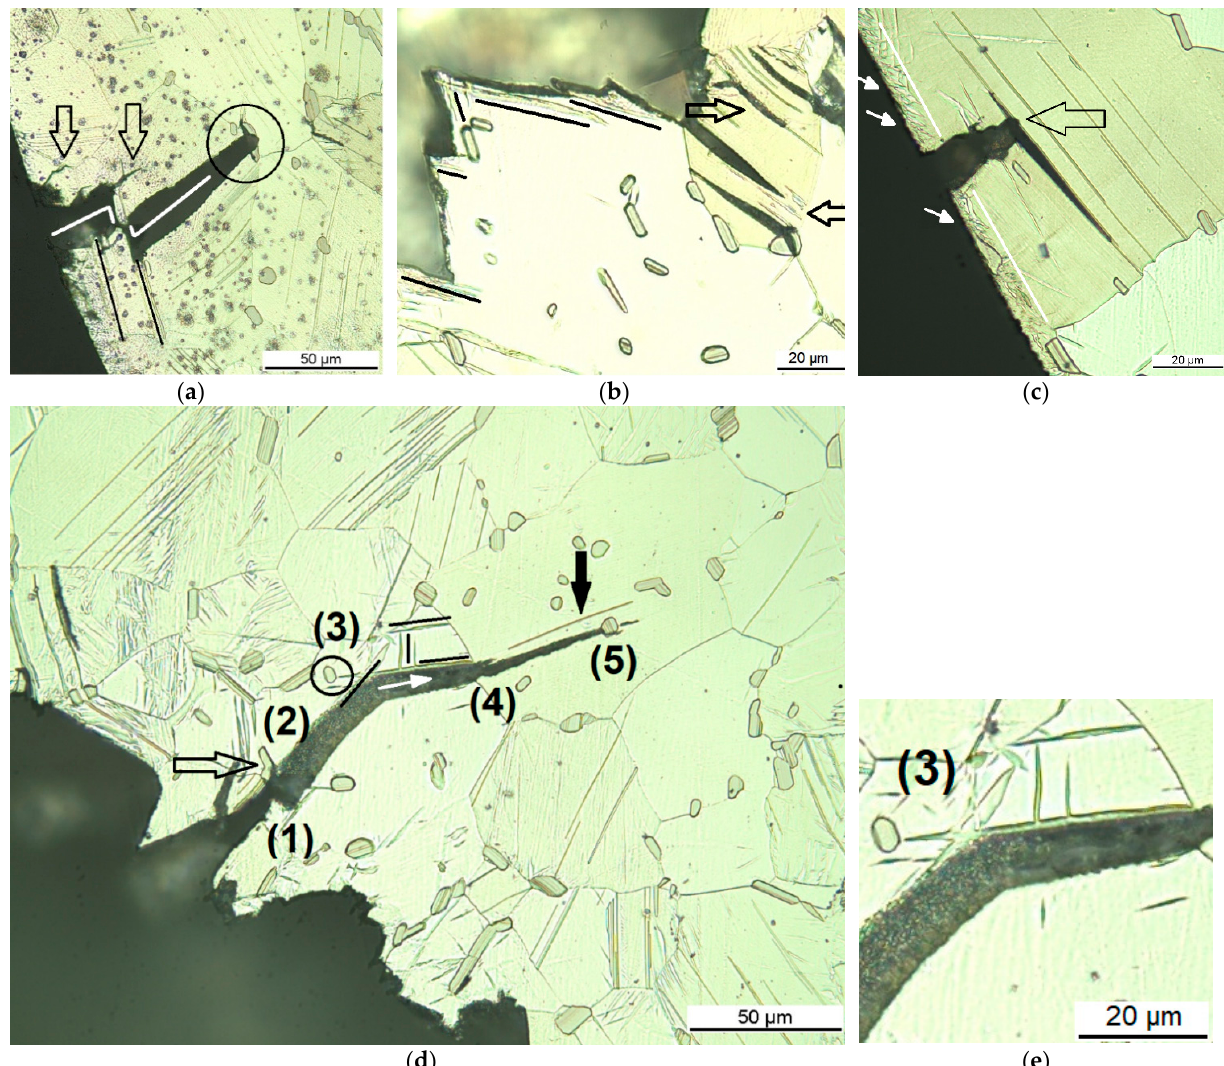
Figure 5. Cross-sectional optical micrographs of the crack path in the Mg-Dy-Nd-Zn-Zr alloy C-ring samples for the Figure 5. Cross ‐ sectional optical micrographs of the crack path in the Mg ‐ Dy ‐ Nd ‐ Zn ‐ Zr alloy C ‐ ring samples for the coarse-grained microstructure: solution heat-treated at 500 ◦ C for 48 h ( a – d ), ( e ) magnified area from micrograph ( d coarse ‐ grained microstructure: solution heat ‐ treated at 500 °C for 48 h ( a – d ), ( e ) magnified area from micrograph ( d ). The cross ‐ sectional micrographs in Figure 6 show the crack path in the solution heat ‐ treated condition at 500 °C for 72 h. Figure 6a,b show a region of a few micro ‐ cracks, either along the lamellar matrix LPSO structures (1) or along twin boundaries (2), where the black lines point out the twins. Additionally, a weak interface between the Mg ‐ matrix and a blocky LPSO phase forming a void can be seen in Figure 6a at the top middle (3) as well as a sub ‐ crack parallel to LPSO lamellae (4). When there are coarser grains free of twins and blocky LPSO phases, as in Figure 6c, the crack runs continuously, following the lamellar matrix LPSO structure through the grain (bottom arrow), and is deflected at the approaching gb or rather by the different orientation of the adjacent grain or its microstructural features. Above the larger crack, a micro ‐ crack can be seen along an LPSO lamella, near the blocky LPSO (top arrow).